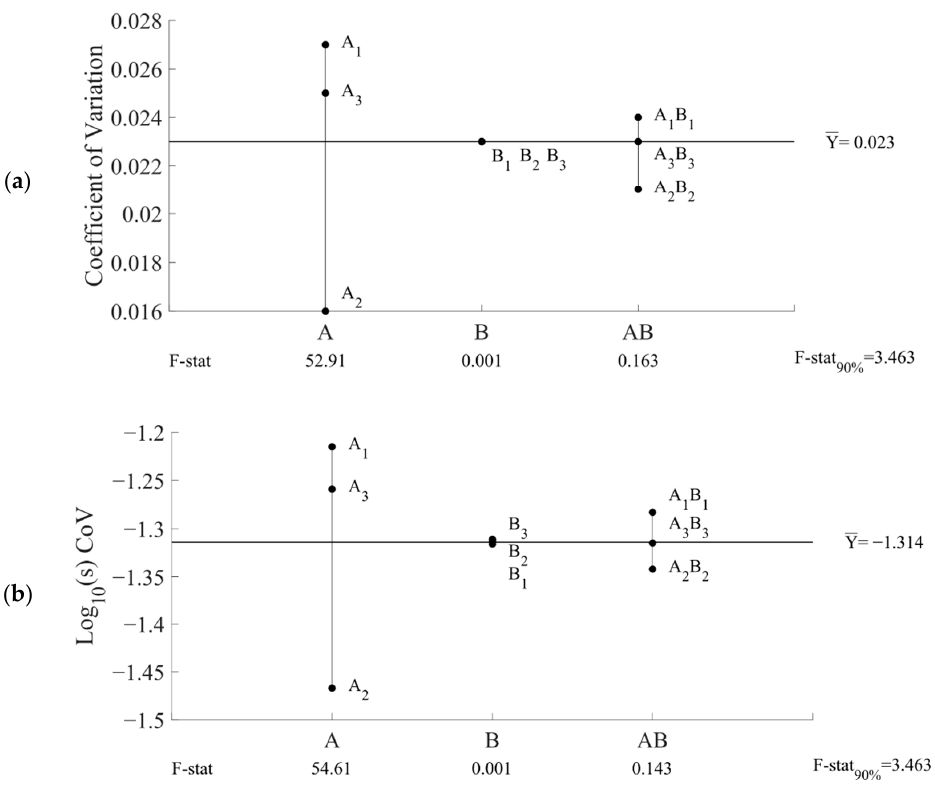
Figure 7. Laminates with convex corners represent ( a ) thickness coefficient of variation and ( b ) variability in the results.